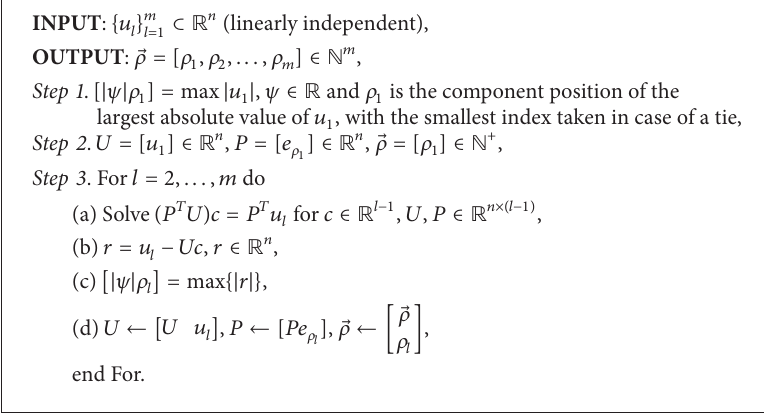
Algorithm 1: DEIM pseudo-algorithm for interpolation indices [18,